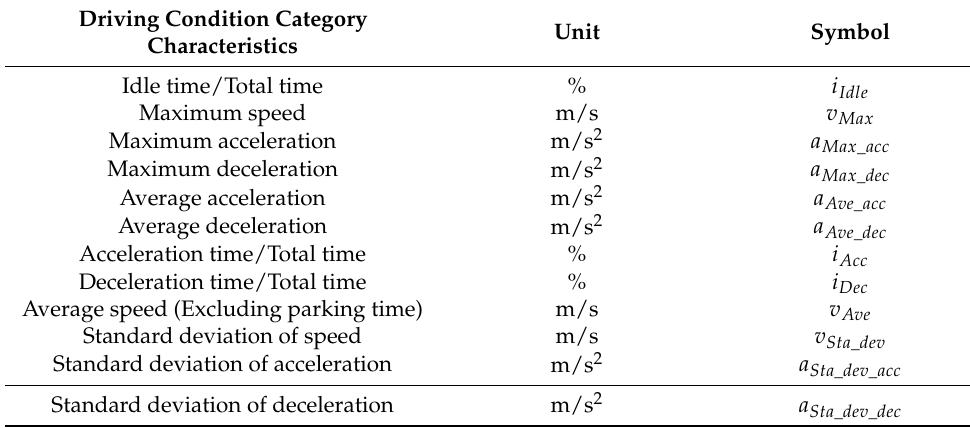
Table 3. The driving condition characteristics table.